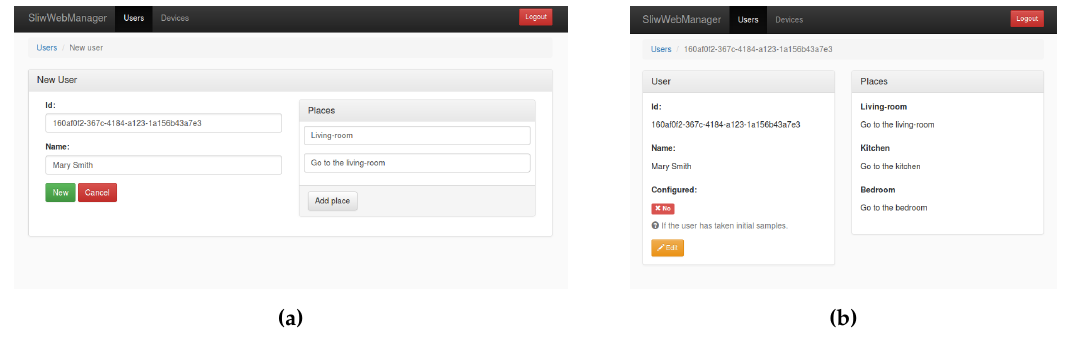
Figure 3. Process for registering a new user. ( a ) Setting up a new user; ( b ) New user created.